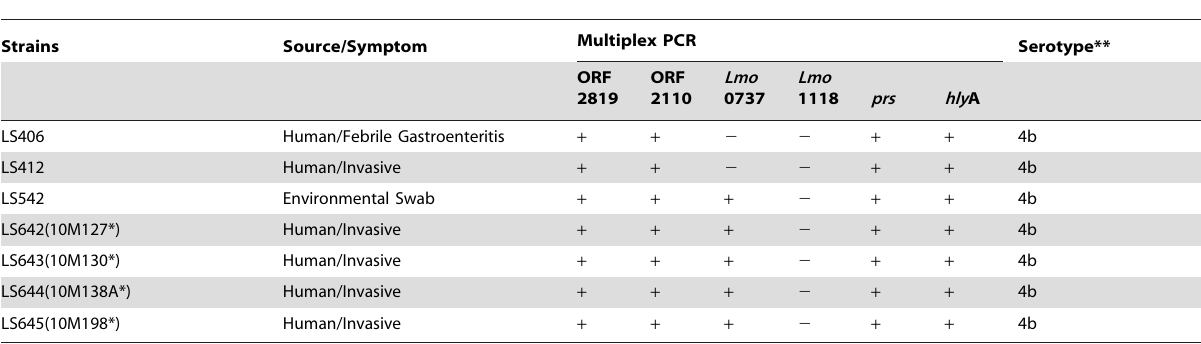
Table 1. L. monocytogenes strains used in this study and their serotypic profiles.